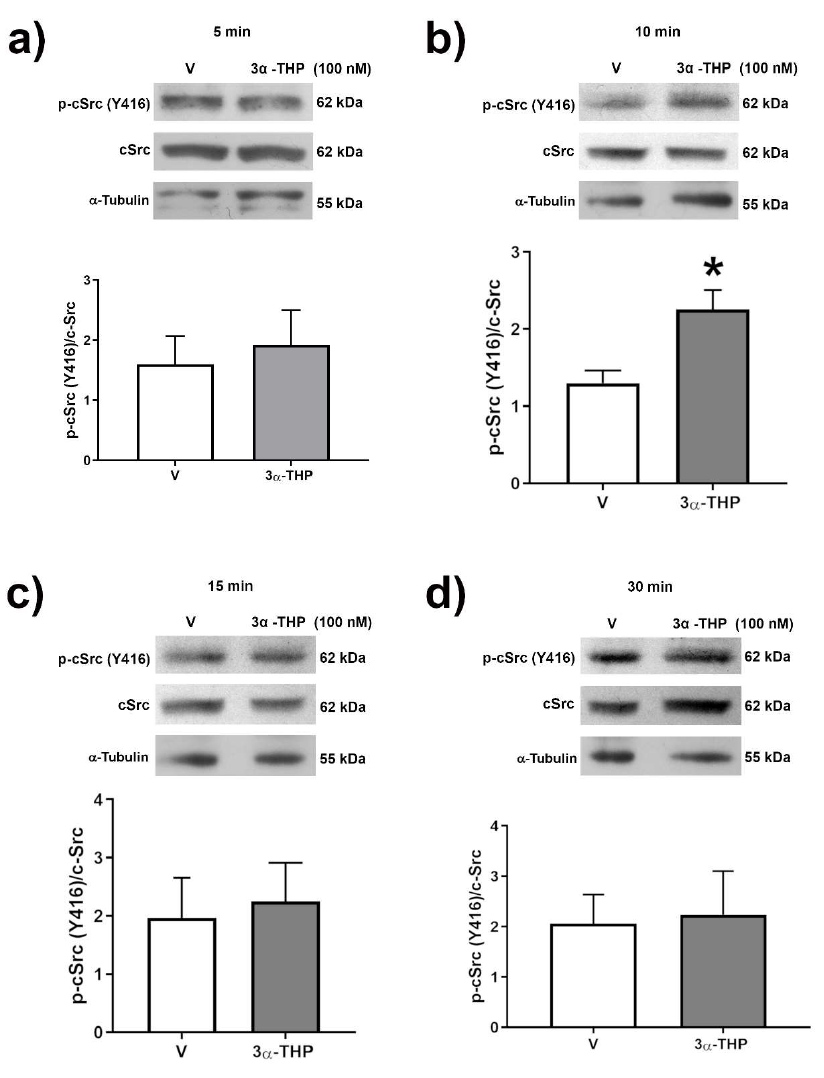
Figure 6. Effect of 3α-THP on c-Src activation in U251 GB cells in time-course experiments. The phosphorylation of c-Src (Y416) was determined under the treatments of 3α-THP 100 nM or Vehicle (V, EtOH 0.01%) at ( a ) 5 min; ( b ) 10 min; ( c ) 15 min; ( d ) 30 min by Western blot. The upper panel of each section shows a representative Western blot experiment of p-c-Src, total c-Src, and α-Tubulin